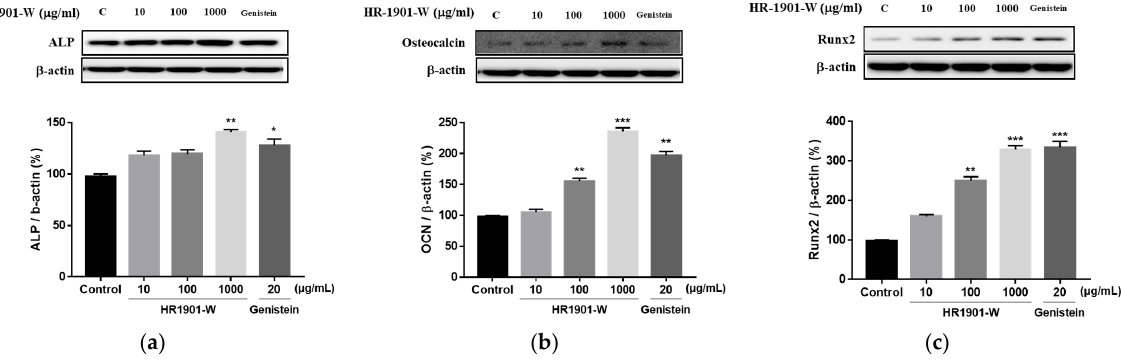
Figure 3. Effects of HR1901-W on the protein expression levels of alkaline phosphatase (ALP), oste- ocalcin (OCN), and runt-related transcription factor 2 (Runx2) in MC3T3-E1 cells. Respective im- munoblot images of the protein expression levels of ALP, OCN, and Runx2 affected by HR1901-W. Relative protein levels of ALP, OCN, and Runx2 densitometrically quantified with β -actin in HR1901-W-treated MC3T3-E1 cells ( a – c ). As a positive control, 20 μ g/mL of genistein was used. All values are expressed as the mean ± standard deviation. * p < 0.05, ** p < 0.01, and *** p < 0.001 when compared with the control.